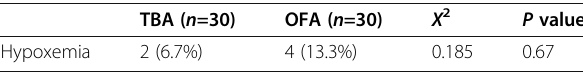
Table 7 compares the visual analog scores of different